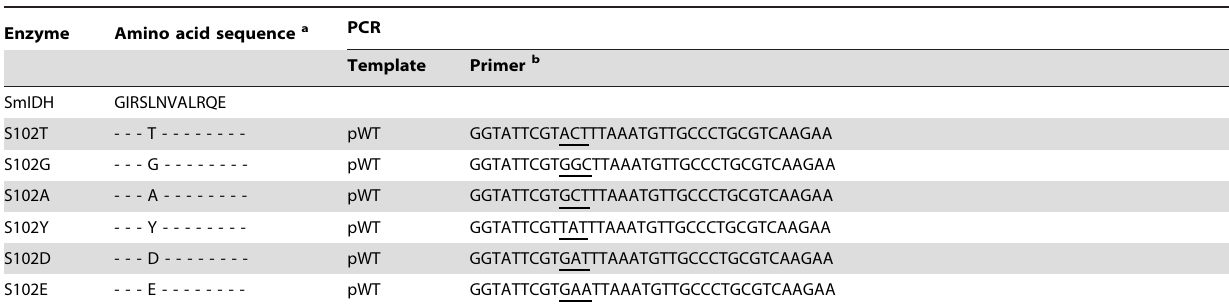
Table 1. Construction of SmIDH mutants.